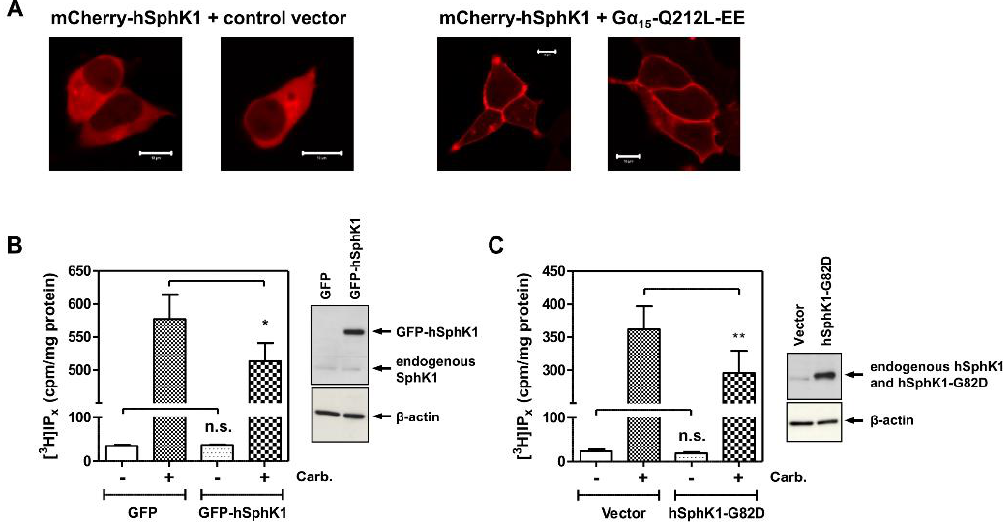
Figure 3. ( A ) SphK1 translocation by constitutively active G α 15 . HEK-293 cells stably expressing the M 3 receptor were transfected with mCherry-hSphK1 and either control vector or G α 15 -Q212L-EE. Shown are two representative images each. Bars, 10 µ m. ( B , C ) Influence of SphK1 overexpression on M 3 receptor-induced inositol phosphate production. HEK-293 cells were transfected with GFP or GFP-hSphK1 ( B ), or with the pcDNA3.1 vector or hSphK1-G82D ( C ). The formation of [ 3 H]inositol phosphates ([ 3 H]IP x ) was measured in [ 3 H]inositol-labelled cells stimulated with 100 µ M carbachol (Carb.) for 20 min in the presence of LiCl. The expression of GFP-hSphK1 and hSphK1-G82D was confirmed with an anti-SphK1 antibody. The data are means ± SEM from n = 9 (B) or n = 8 (C) independent experiments, each performed in triplicate. Note: n.s., not significant; * p < 0.05, ** p = 0.01 in paired t -test.